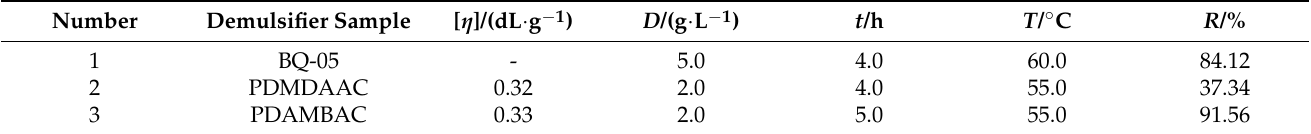
Table 9. Comparison of demulsification performance with other